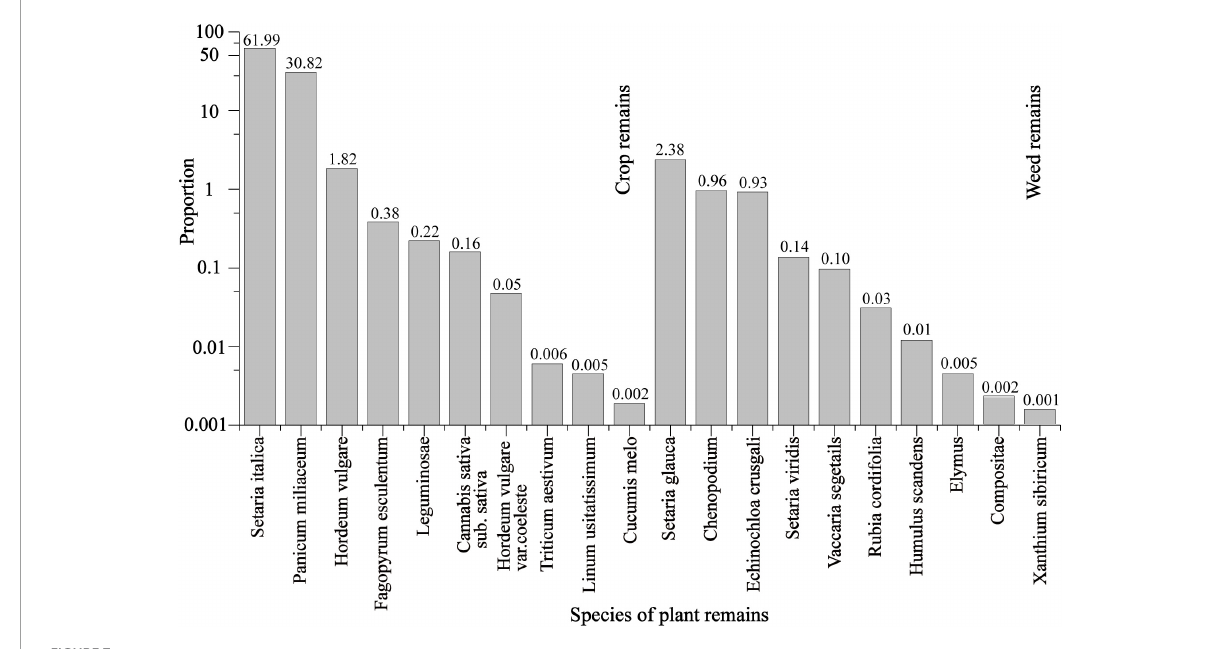
FIGURE7 The proportion of different plant remains from the Chashancun